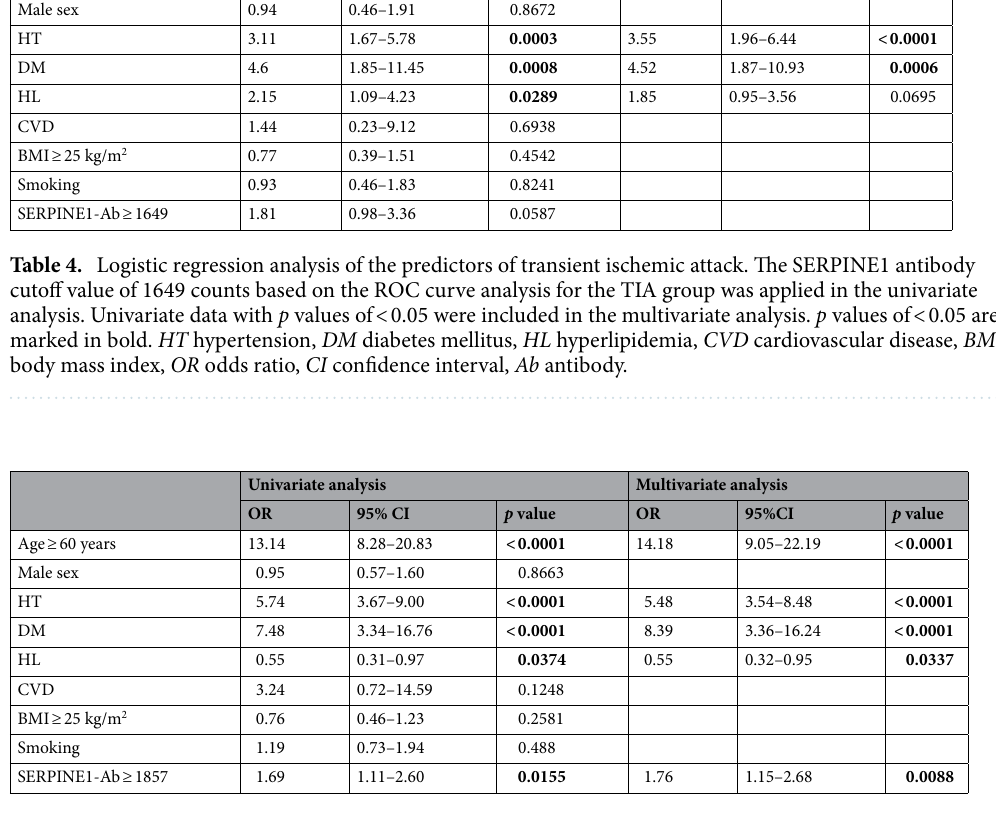
Table 5. Logistic regression analysis of predictors of acute cerebral infarction. The SERPINE1 antibody cutoff value of 1857 counts based on the ROC curve analysis for the aCI group was applied in the univariate analysis. Univariate data with p values of < 0.05 were included in the multivariate analysis. p values of < 0.05 are marked in bold. HT hypertension, DM diabetes mellitus, HL hyperlipidemia, CVD cardiovascular disease, BMI body mass index, OR odds ratio, CI confidence interval, Ab